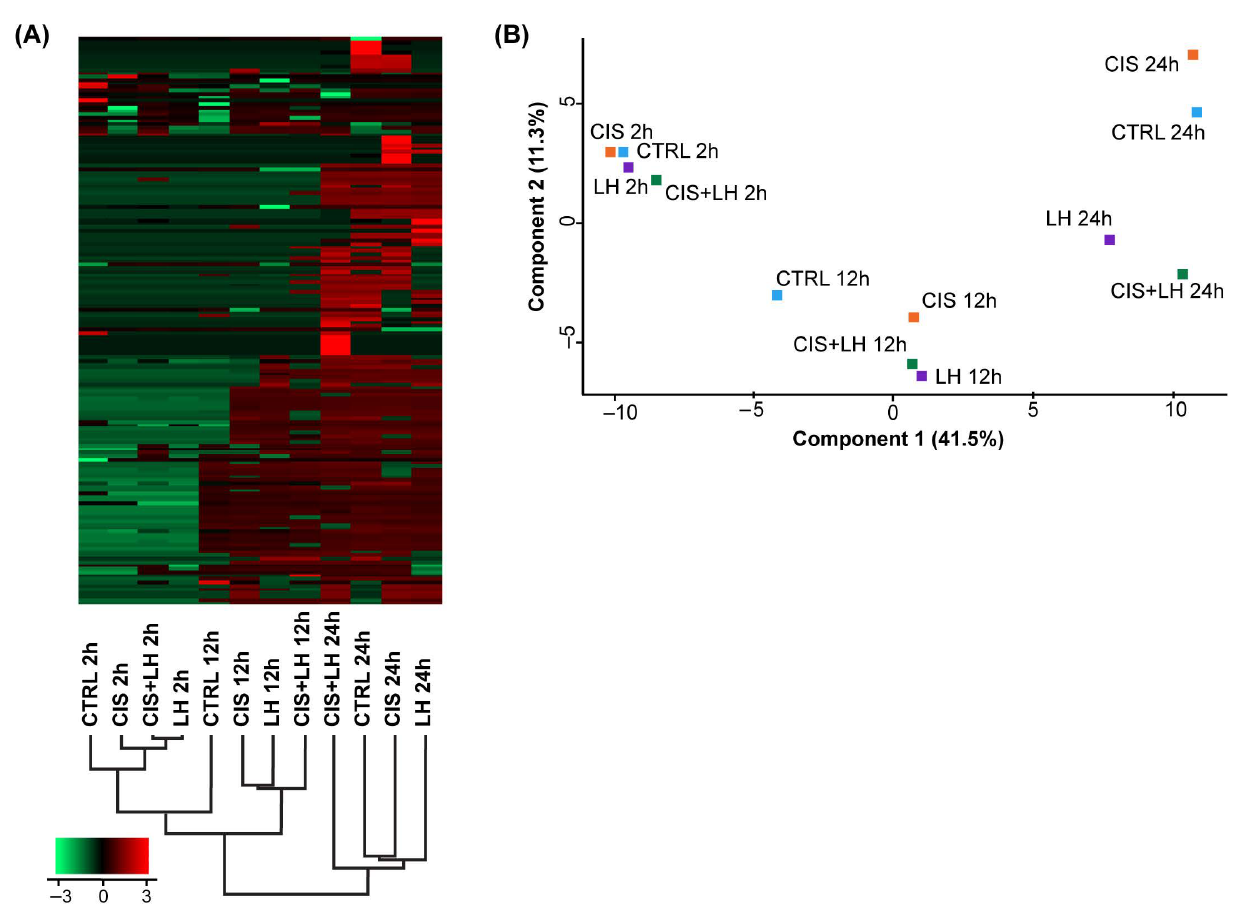
Figure 1. Heatmap combined with hierarchical clustering and principal component analysis (PCA) of FCM after 2, 12, and 24 h of treatment. In ( A ) a heatmap comparison of the 148 secreted metabolites, with two or more unique peptides and a 100% confidence, is depicted. Protein iBAQ values were log 2 -normalized, and cluster analysis was performed using Z-score protein intensities. Red indicates a high expression level; green indicates a low expression level. In ( B ) PCA analysis plot of FCM at 2, 12, and 24 h after